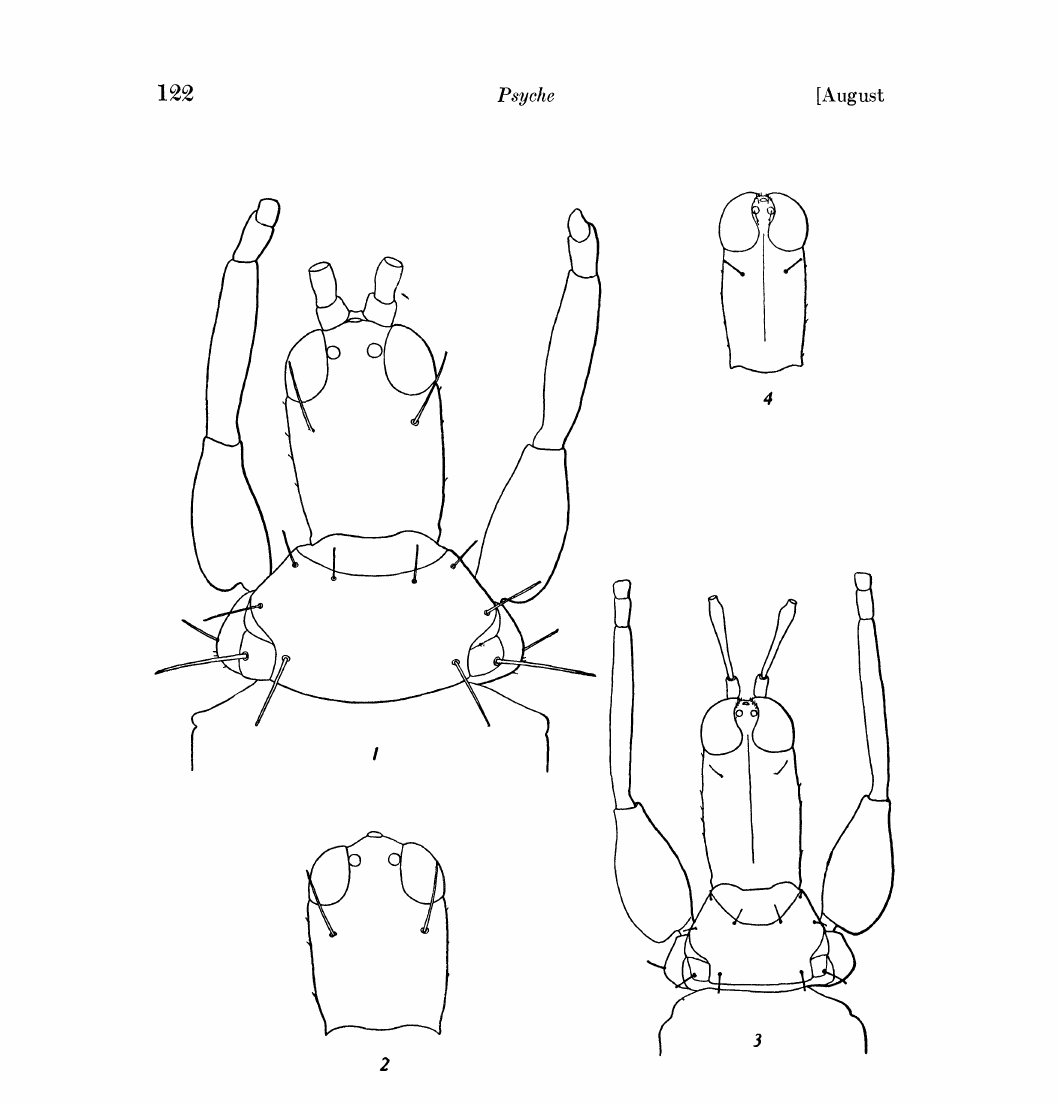
. Fig. 1. Liothrips zeteki sp. nov., head and prothorax, female. Liothrips zeteki, head of male. Fig. Fig. 3. Polyommatothrips vigilans sp. nov., head and prothorax, female. Fig. 4. Polyommatothris vigilans, head of